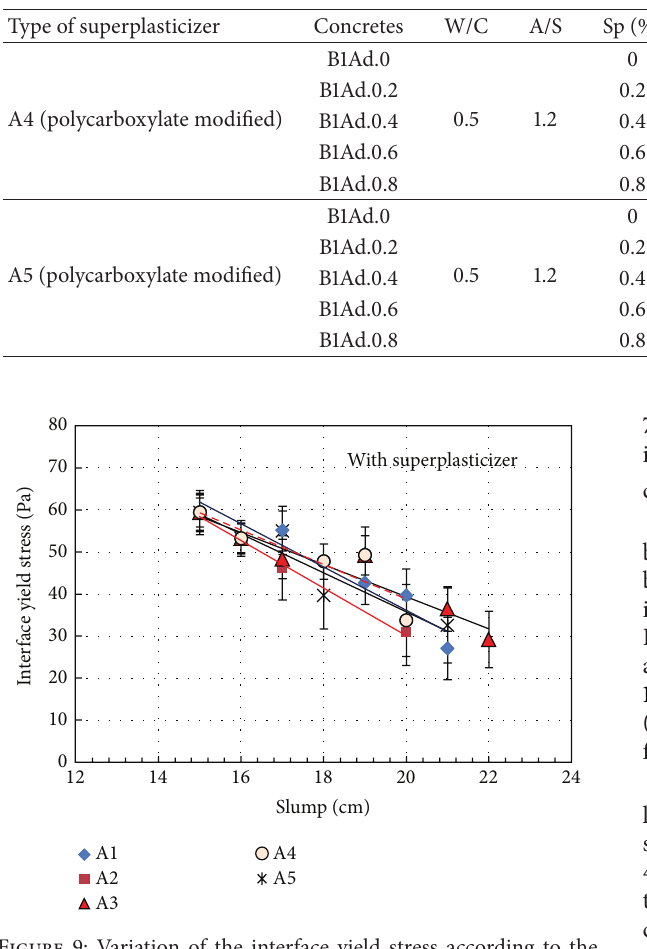
Figure 9: Variation of the interface yield stress according to the concrete